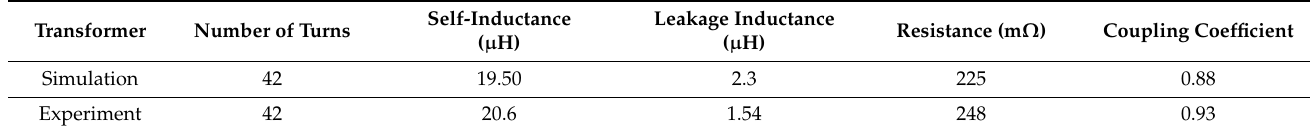
Table 3. Transformer simulation